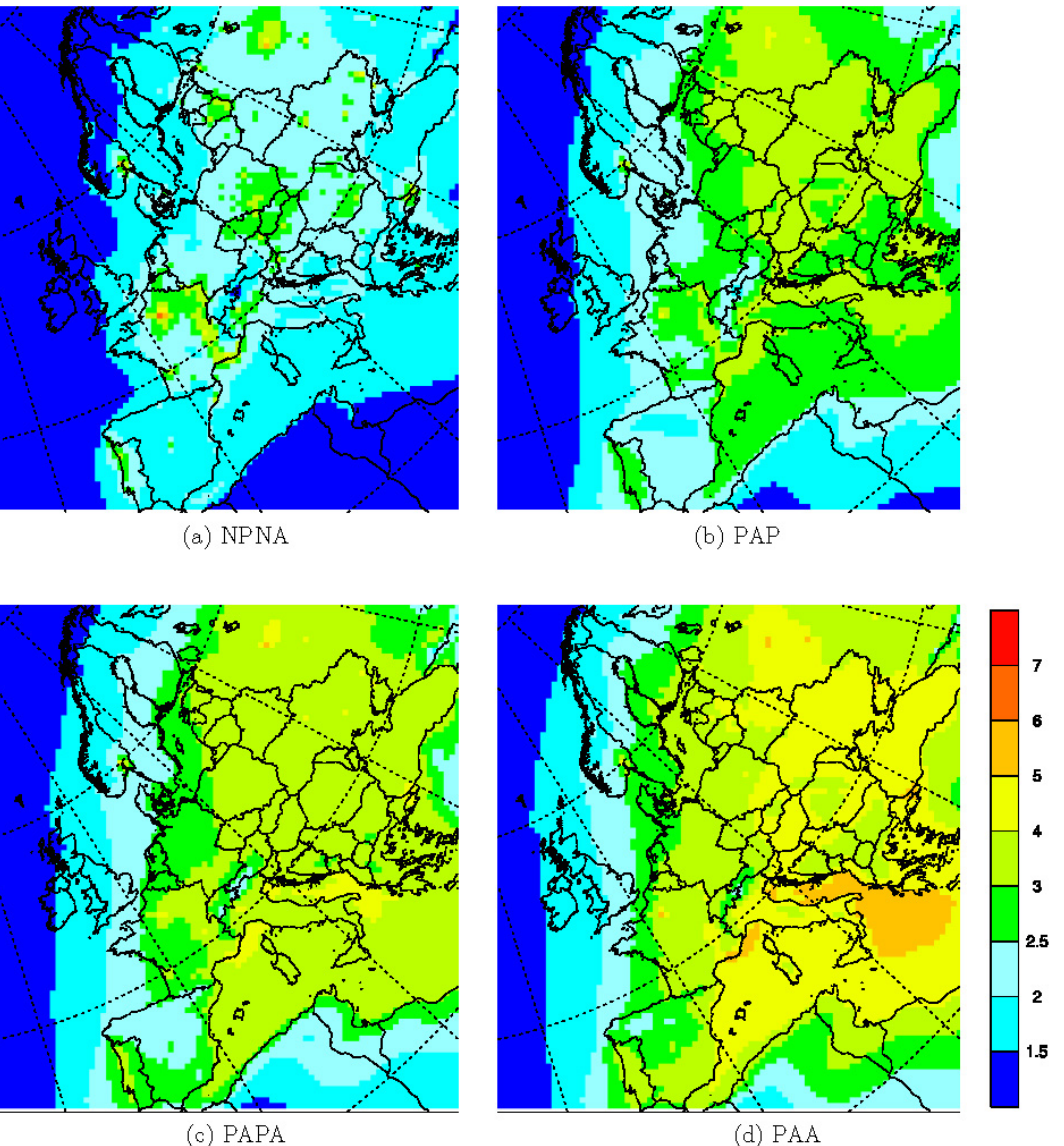
Fig. 3. Total Organic Matter in PM 2 . 5 (OM PM ). 6-yr average concentration (for the period 2002–2007) calculated with the EMEP-PCM 2 . 5 model. Comparison between four different model versions (see text). Unit: µg m − 3